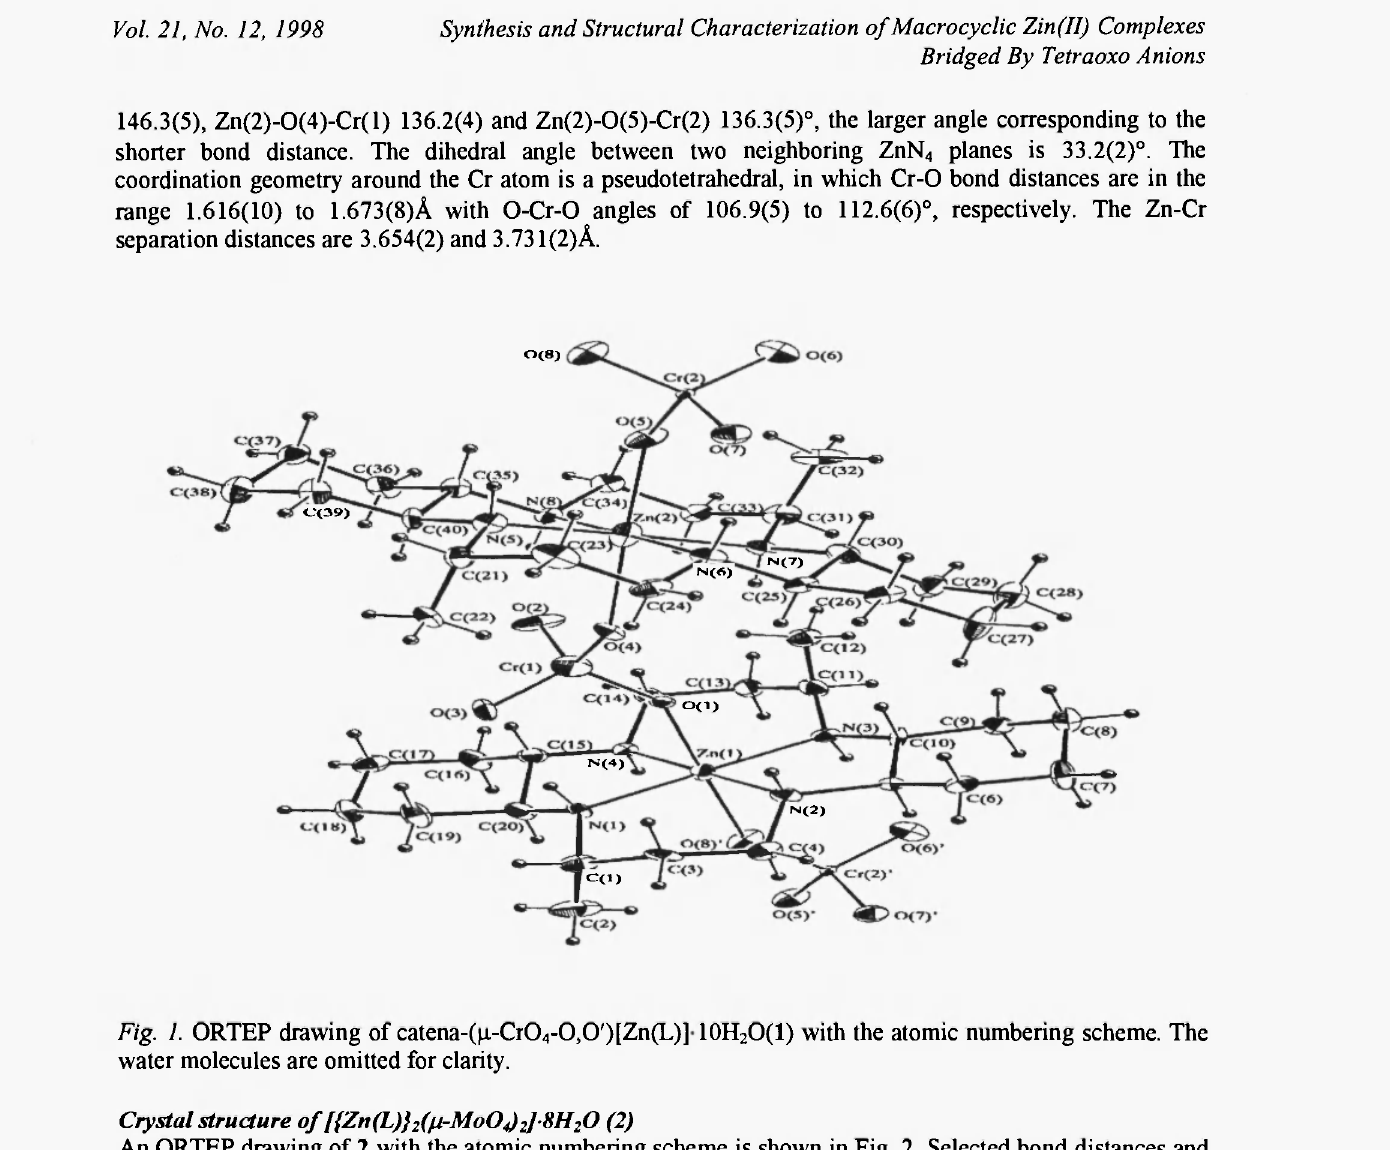
Fig. 1. ORTEP drawing of catena-^-Cr0 4 -0,0')[Zn(L)]10H20(l) with the atomic numbering scheme. The water molecules are omitted for